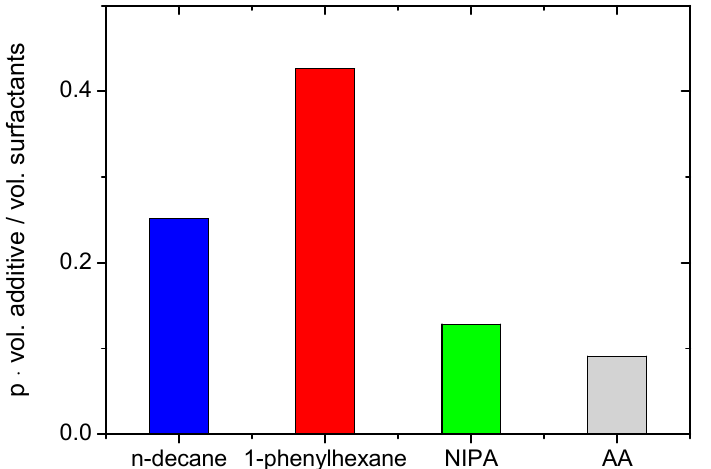
Figure 8. Relative volumes of various additives (v rel = p · vol. additive/vol. surfactant) inside surfactant aggregates corresponding to the minimum additive concentration necessary to reach minimum viscosity (corresponding to the cross-over from Range 2 to Range 3, see Table 1).